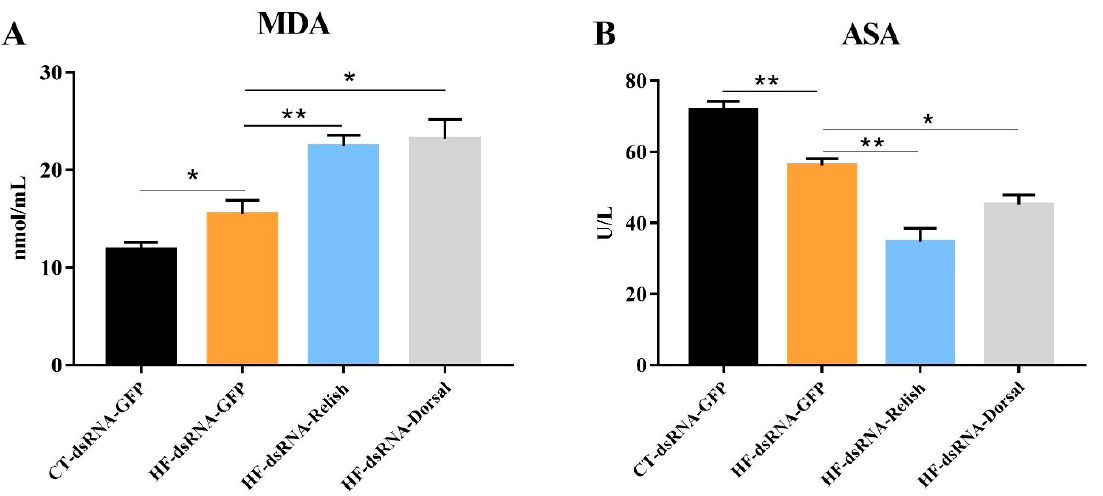
Figure 10. Hemolymph ASA activity and MDA content of Macrobrachium rosenbergii after knock-down by dsRNA-mediated RNA interference. ( A ) Hemolymph anti-superoxide anion (ASA) activity of M. rosenbergii after RNA interference; ( B ) Hemolymph malonaldehyde (MDA) content of M. rosenbergii after RNA interference. Values are means ± SEM. **: p < 0.01, *: p < 0.05.